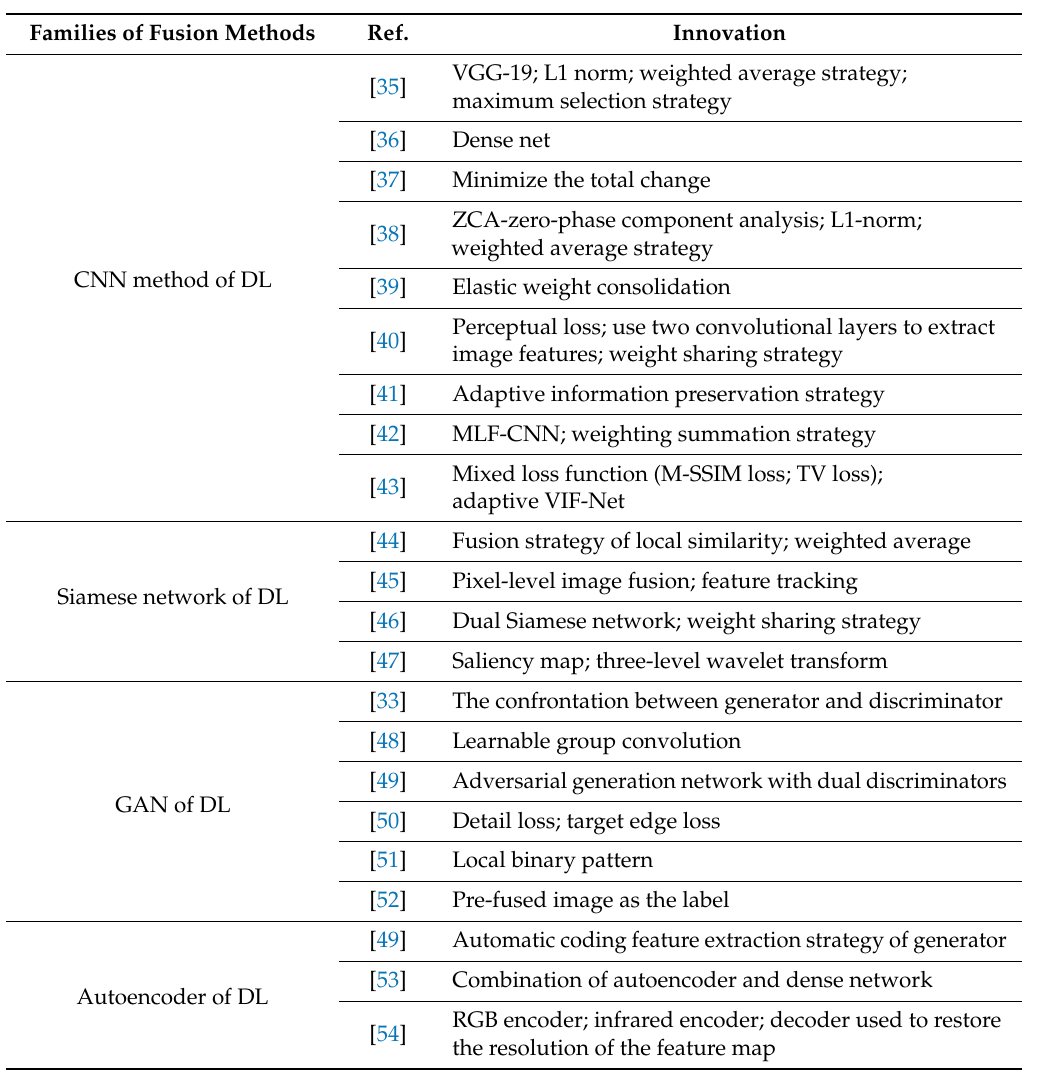
Table 1. The overview of some deep learning (DL)-based fusion